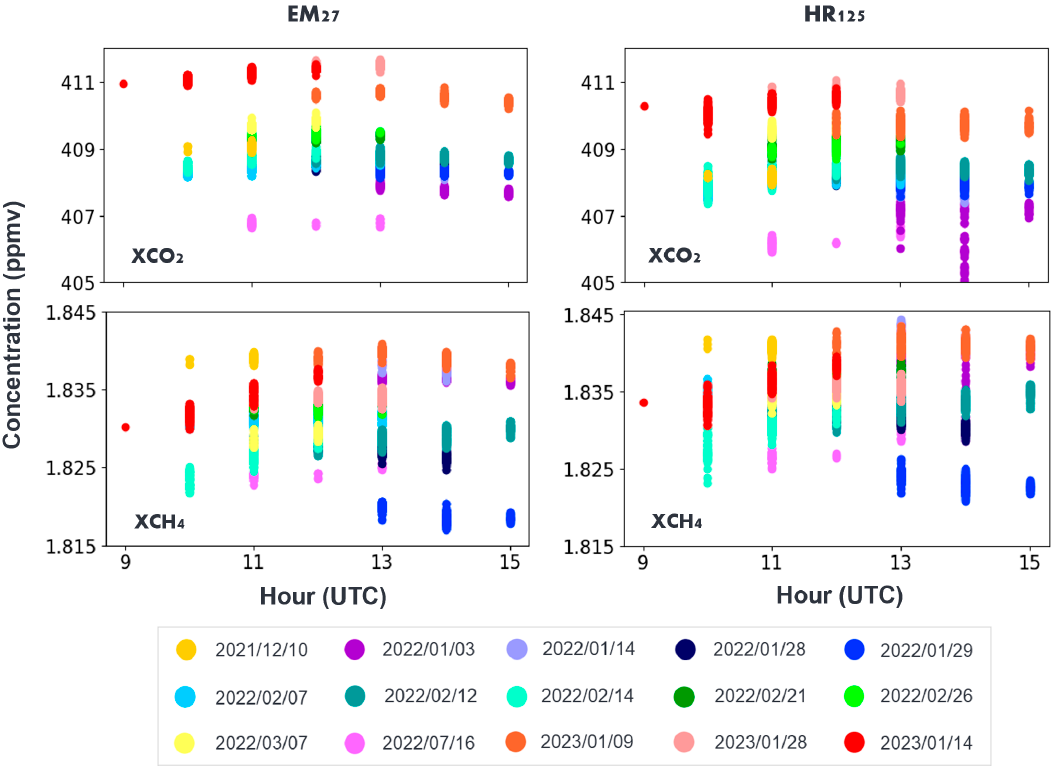
Figure 26. EM27/SUN and TCCON-HEFEI multi-day XCO 2 and XCH 4 observation results.